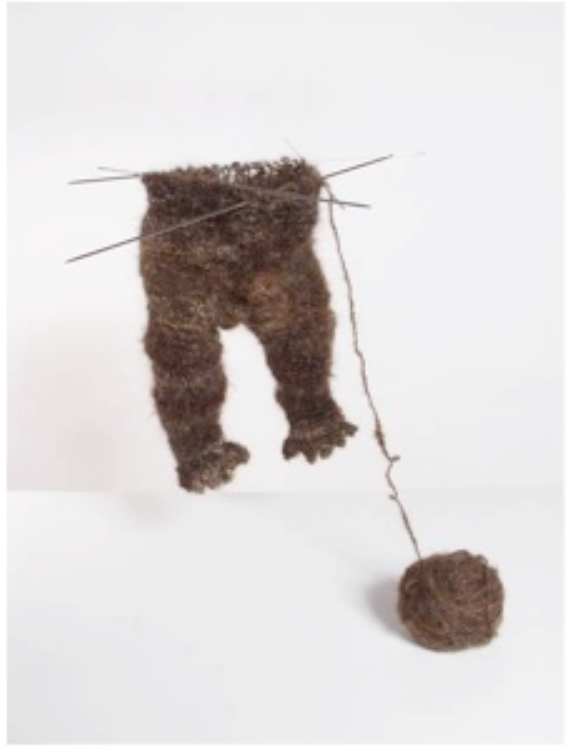
Heather Hanna, A Visual Essay: Interventions and Manipulations in the Maternal Studies in the Maternal, 4(1), 2012,